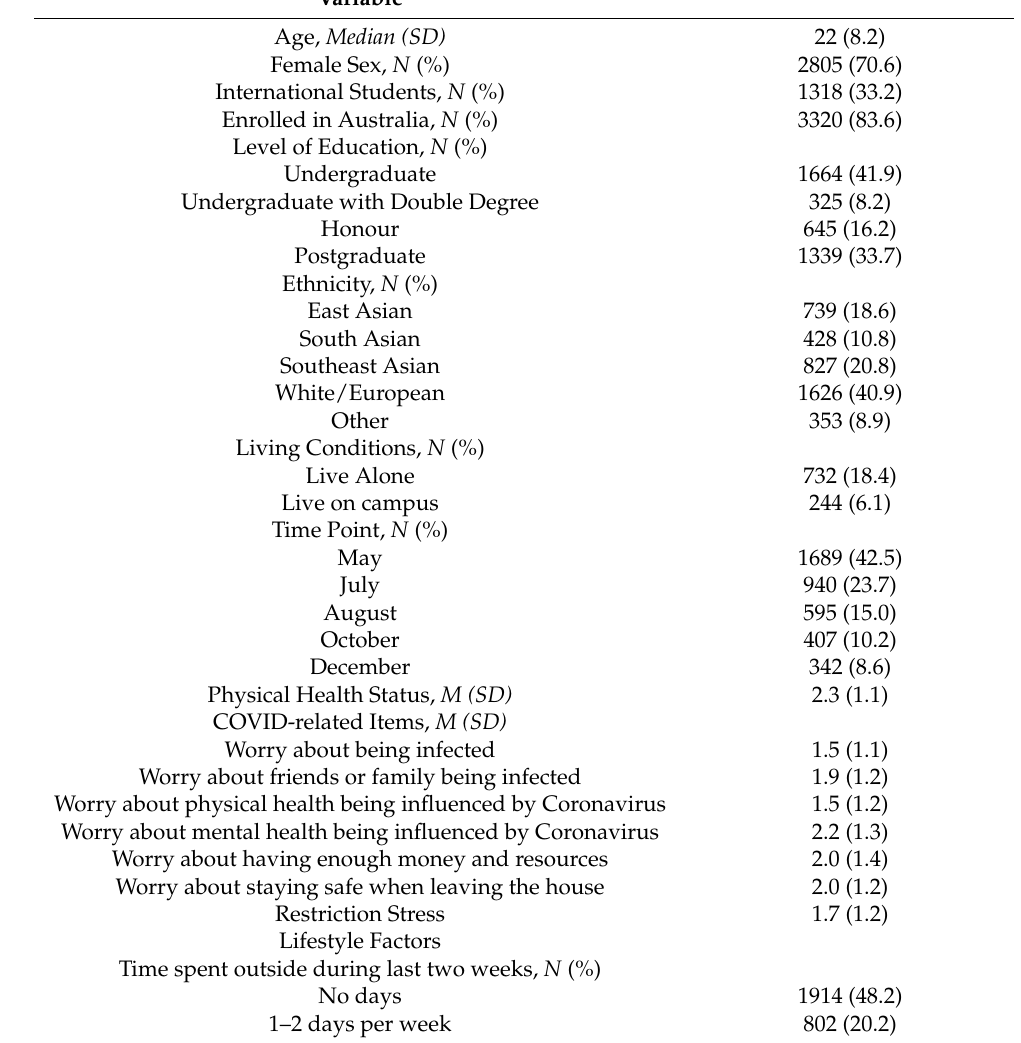
Table 1. Participants